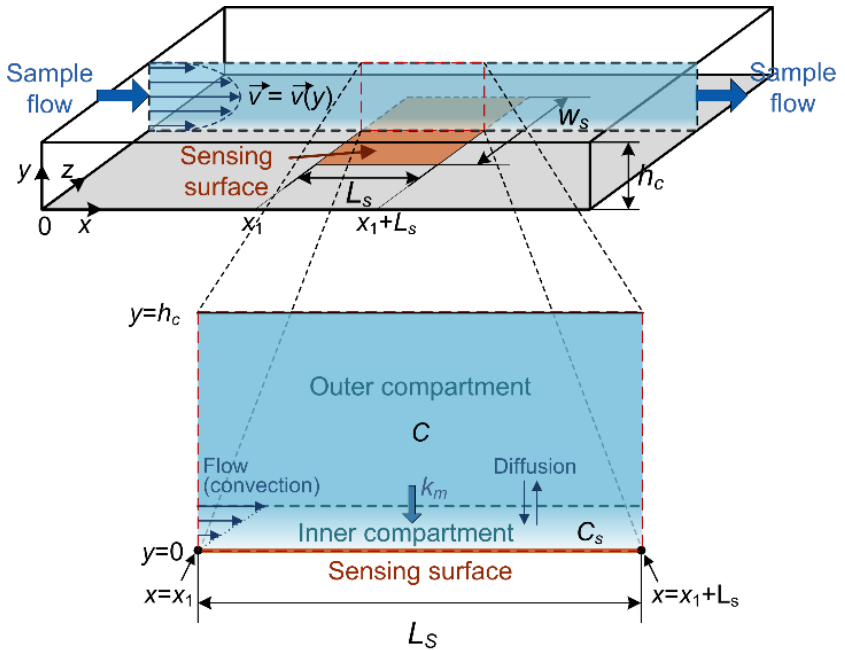
Figure 1. Adsorption-based microfluidic sensor: schematic representation of the typical system geometry with designations of dimensions and coordinate axes. The magnified partial cross-section of the microfluidic reaction chamber in the sensing surface zone is given as an illustration of the two-compartment model approximation of the spatially and time-dependent target substance concentration, affected by coupled adsorption–desorption and mass transfer processes of target analyte particles. The random nature of the AD process coupled with MT causes fluctuations in the number of adsorbed particles, which result in sensor signal stochastic fluctuations known as AD noise, binding/unbinding noise, biological or chemical noise [15–19]. The total fluctuations in the sensor signal also depend on other kinds of noise originating from the sensor transduction mechanism and the read-out circuitry, but the unavoidable AD noise determines the sensor’s ultimate noise performance and poses fundamental detection and quantification limits inherent to all adsorption-based sensors. The contribution of AD noise to the total sensor noise can even be dominant [16,17,20,21]. Thus, the analysis of AD noise and related parameters of stochastic sensor response becomes an important tool for the optimization of adsorption-based chemical and biological microfluidic sensors in terms of reliable analyte detection and quantification, and also in terms of improved sensing performance (i.e., higher signal-to-noise ratio and lower minimal detectable and quantifiable concentrations). This is especially true because miniaturization is a general trend in the field of chemical and biological sensors, focusing on adsorption-based